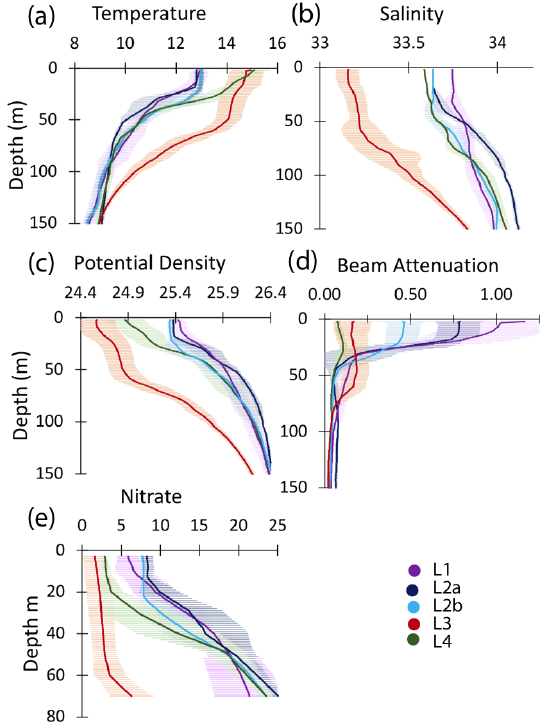
Figure 10. Profiles of averaged T , S , potential density, beam atten- uation coefficient (650nm), and nitrate in the upper 150m at loca- tions L1, L2a, L2b, L3, and L4. Error bars are ±